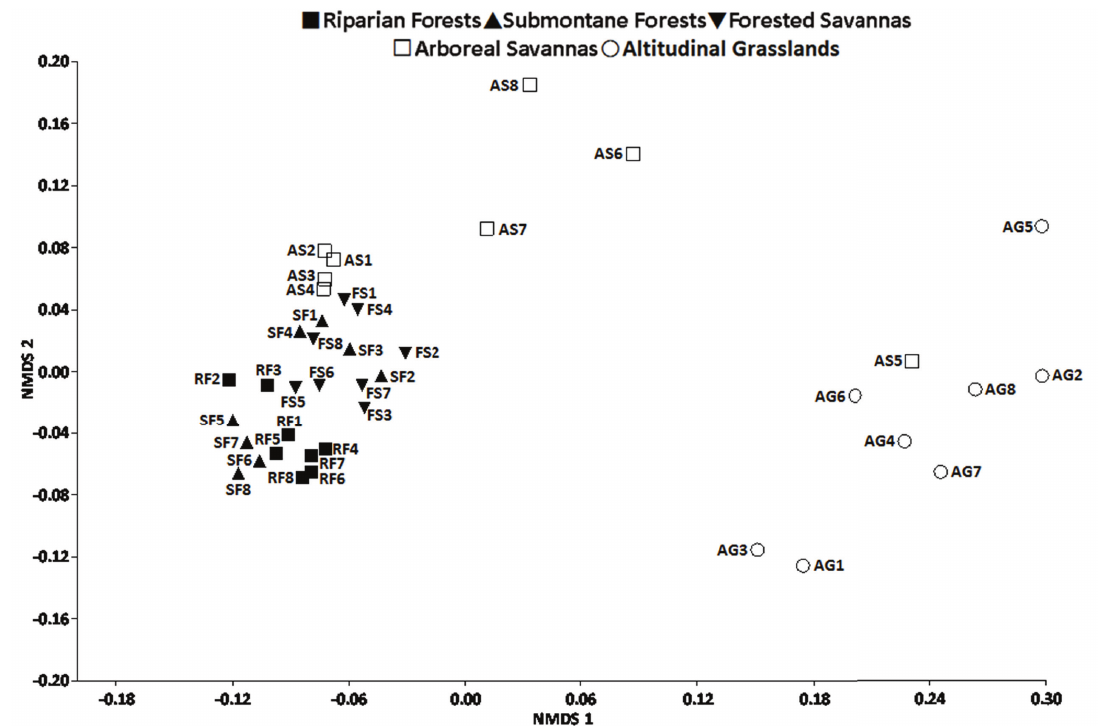
Figure 4 - Non-Metric Multidimensional Scaling (NMDS, Bray-Curtis distance) (Stress = 0.14, R 2 = 0.78) and Anosim (R = 0.53, p ≤ 0.0001) of a bird community in diff erent vegetation types at Maciço do Urucum, western